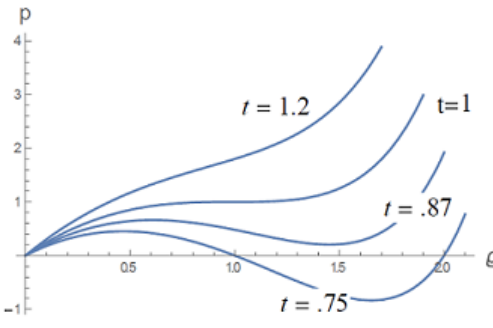
Figure 1. Representative isotherms for the universal (reduced) van der Waals equation of state for a pure fluid. The quantities p , t , and (cid:36) are, respectively, the reduced pressure, temperature, and number density